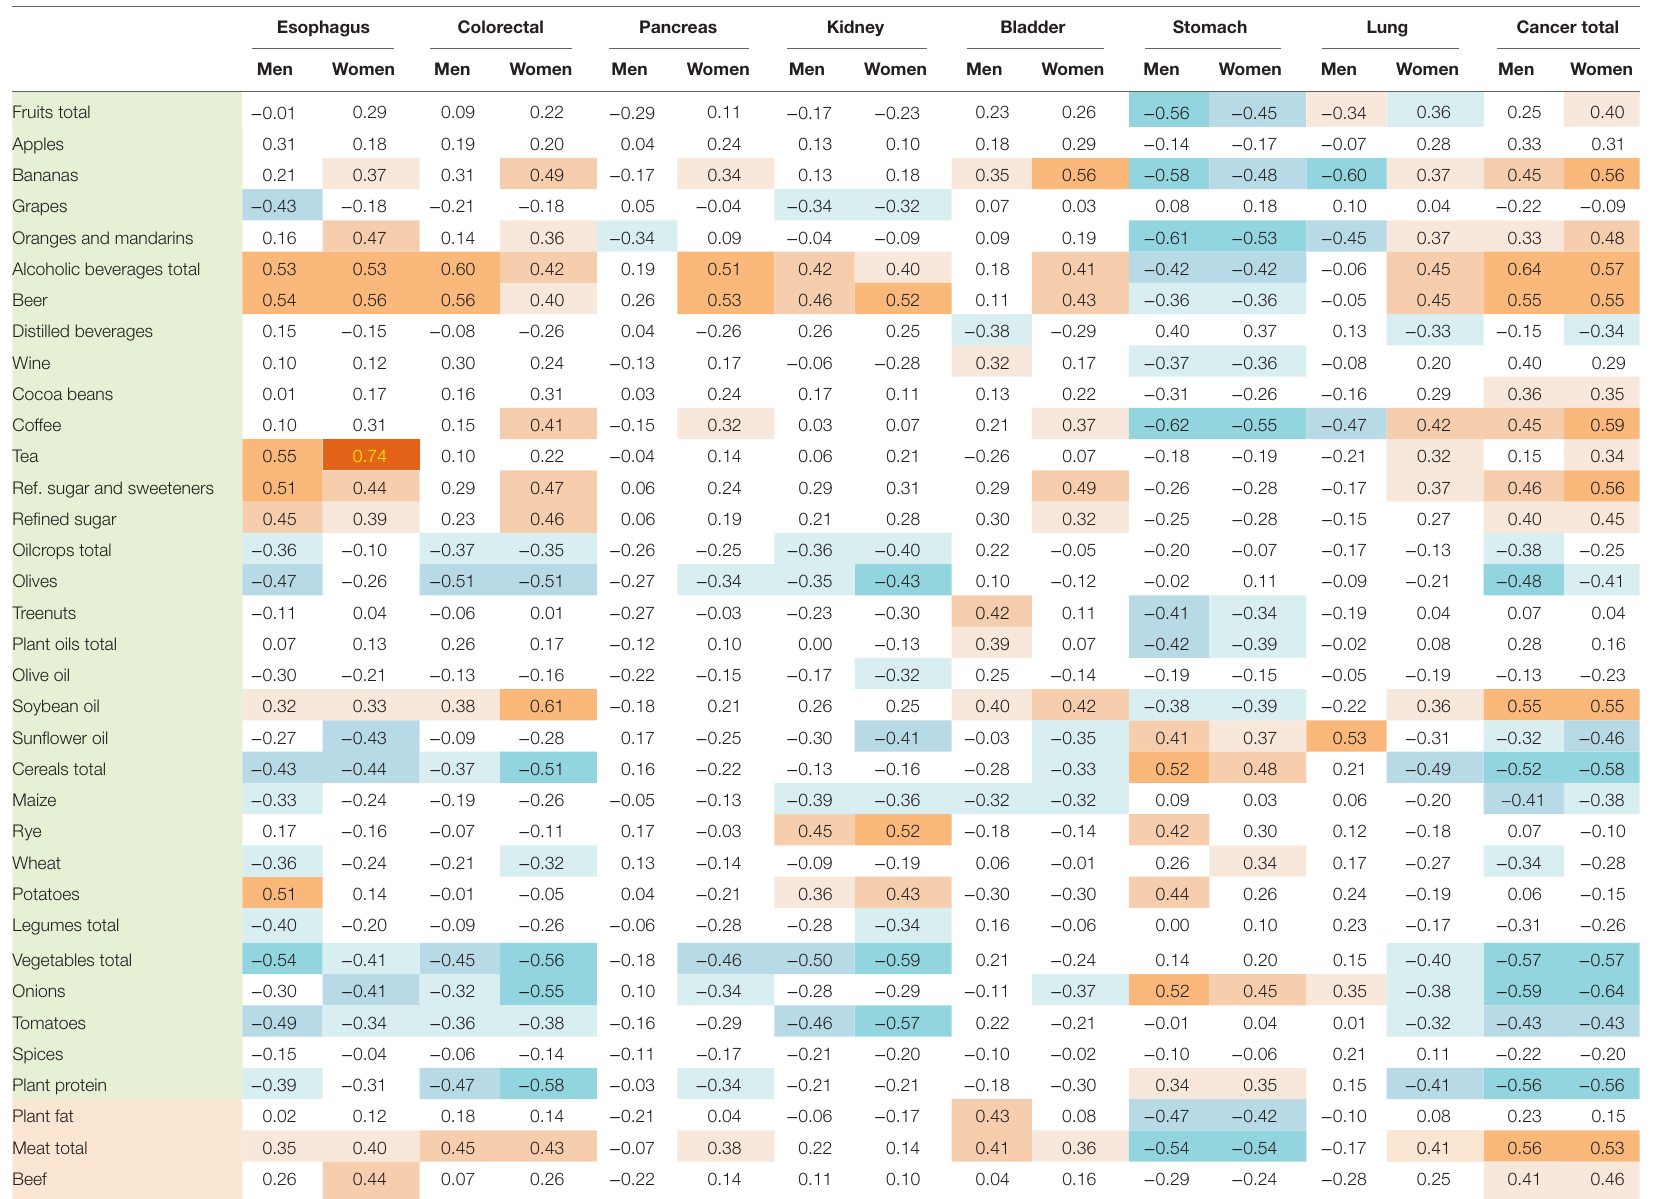
Table 2 | Correlations ( r -values) between seven types of cancer, total cancer incidence, and variables examined in this study (for more detailed results, see Data Sheet S1 in Supplementary Material, Sheet